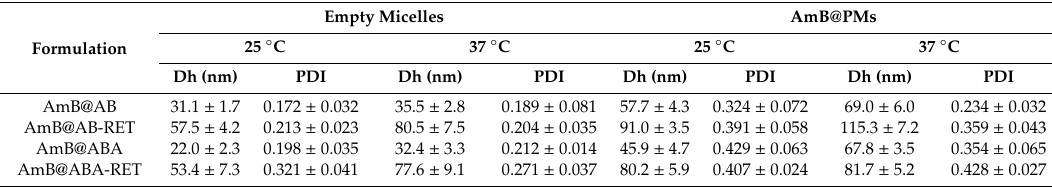
Table 4. Average diameters measured by dyanimc light scattering (DLS) for empty micelles and